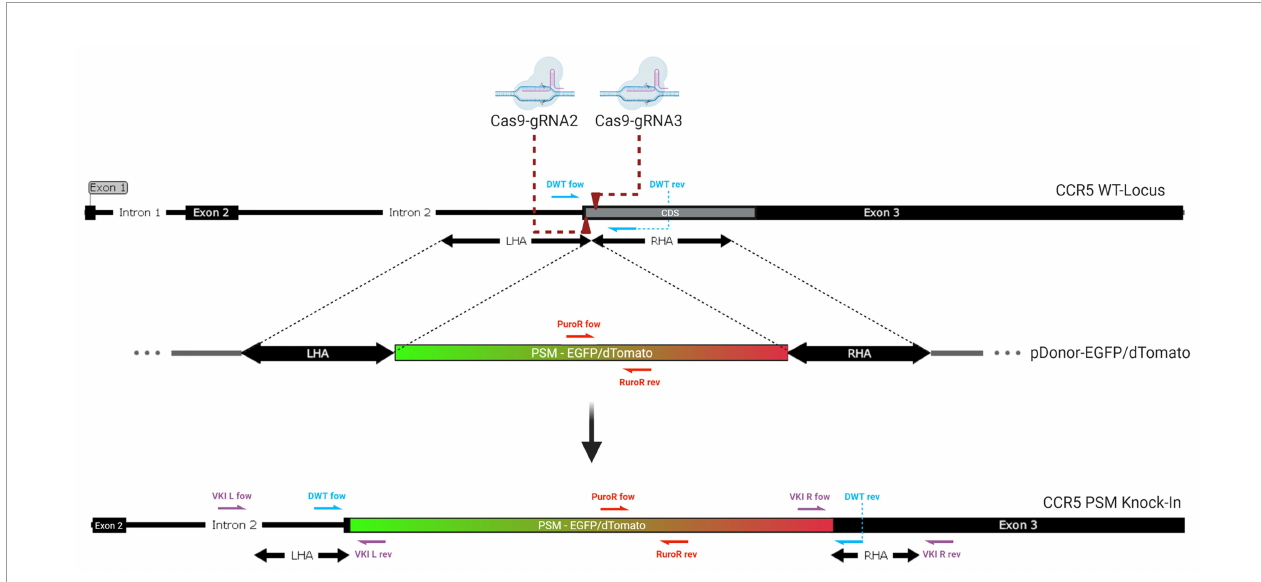
FIGURE 1 | Genomic integration of the donor. Two Cas9-gRNA ribonucleoproteins are directed against closely adjacent sites on the coding sequence (CDS) at the beginning of Exon 3 of the CCR5 gene (dark red arrows). Double stranded breaks lead to integration of a donor template with homologous sequences matching the region surrounding the DSBs. The positive selection module (PSM), a non-homologous graft sequence, which lies between the left (LHA) and right homology arm (RHA) is being integrated into the CCR5 gene as homologous recombination occurs. It contains an expression cassette for either EGFP or dTomato. The knock-in of this long functional sequence creates a massive frameshift mutation, disrupting the CCR5 gene. Half arrows display the location of the primer pairs used for genomic qPCR. (violett: VKI; red: PuroR; blue: